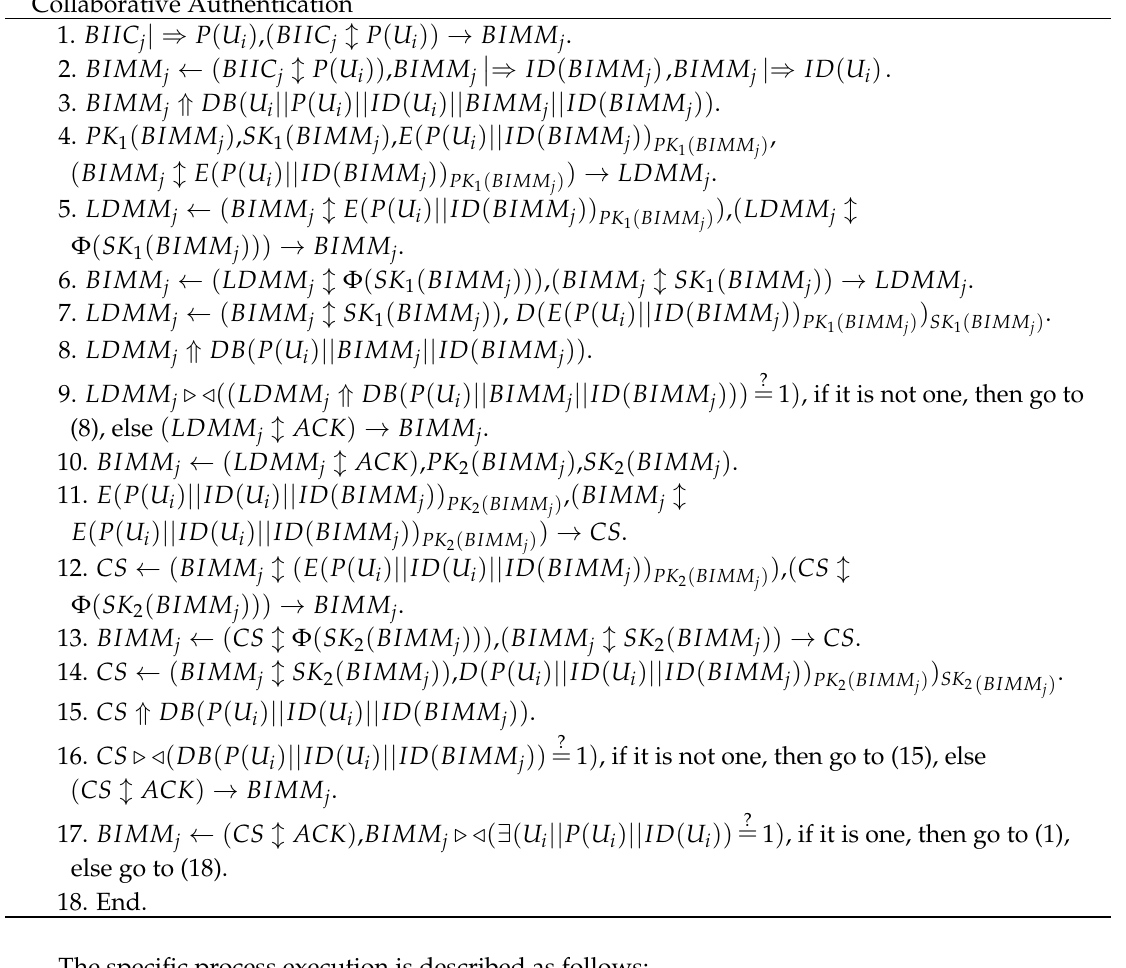
Algorithm 1: The System Establishment Phase of User Image Intelligent Multi-Point Collaborative